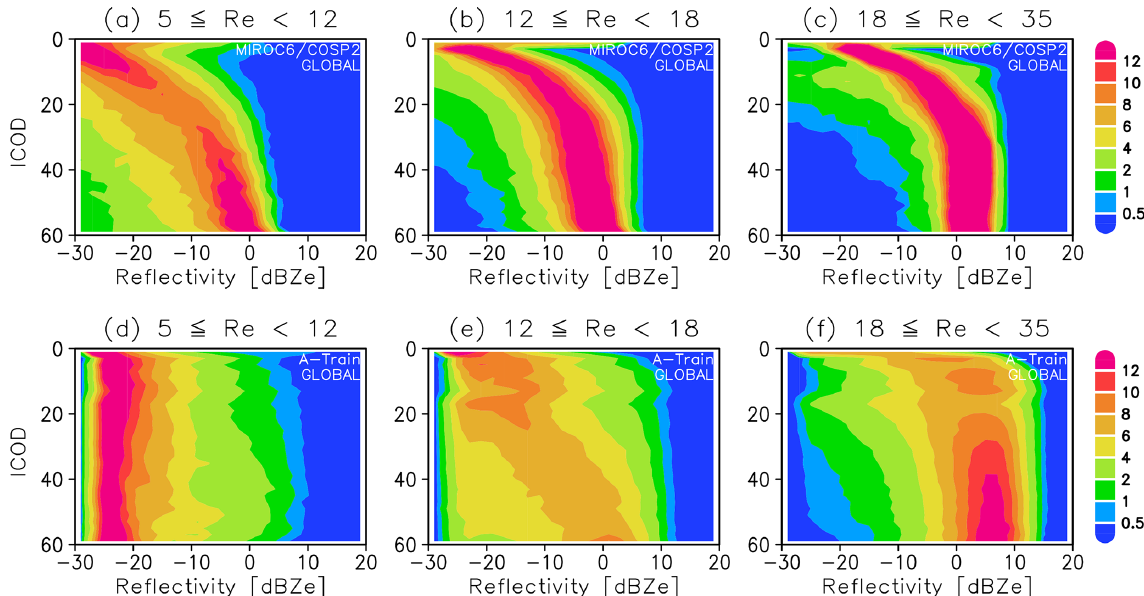
Figure 3. Contoured frequency by optical depth diagrams (CFODDs) obtained from (a–c) the MIROC6–COSP2 one full year simulation and (d–f) the A-Train satellite observations for the period June 2006–April 2011. CFODDs are classified according to the MODIS-derived cloud-top effective radius ( R e ) in the 2.1µm band as (a, d) 5–12, (b, e) 12–18, and (c, f) 18–35µm following Michibata et al. (2014).